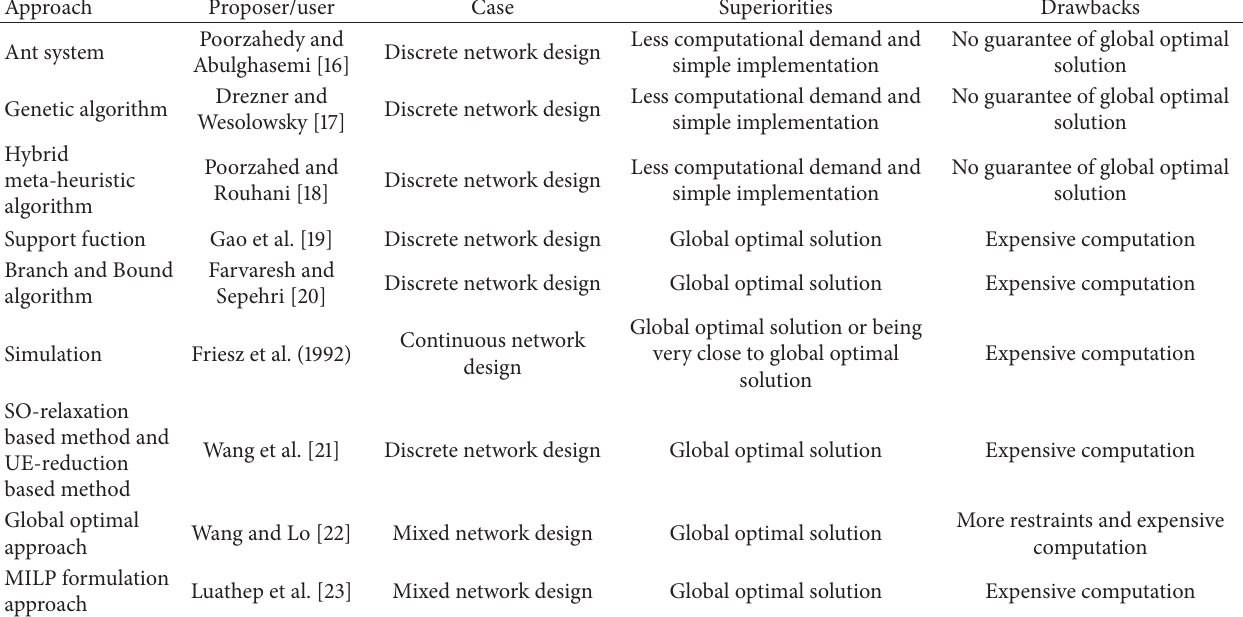
Table 4: Algorithms of network design